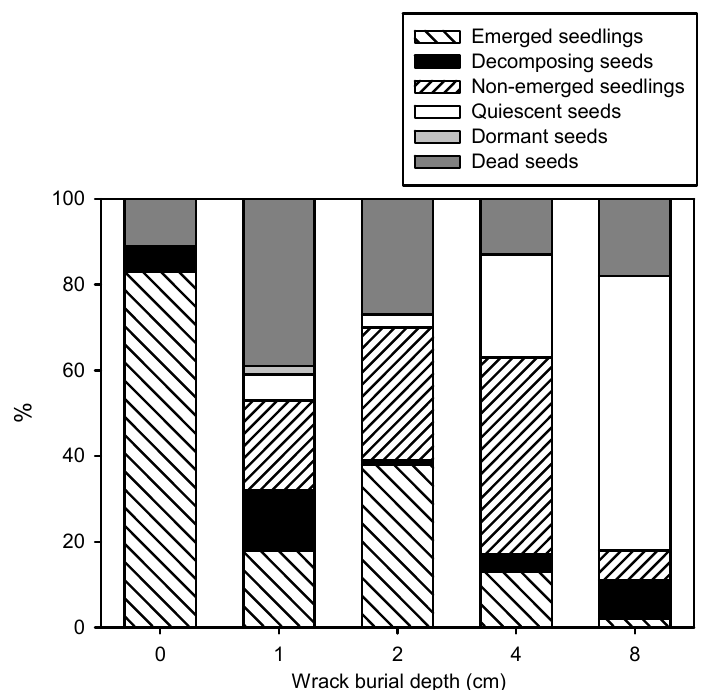
Figure 2. Percentages of seedling emergence, decomposing seeds, non-emerged seedlings, quiescent seeds, dormant seeds, and dead seeds of Iris pseudacorus at different wrack burial depths. Values are means.